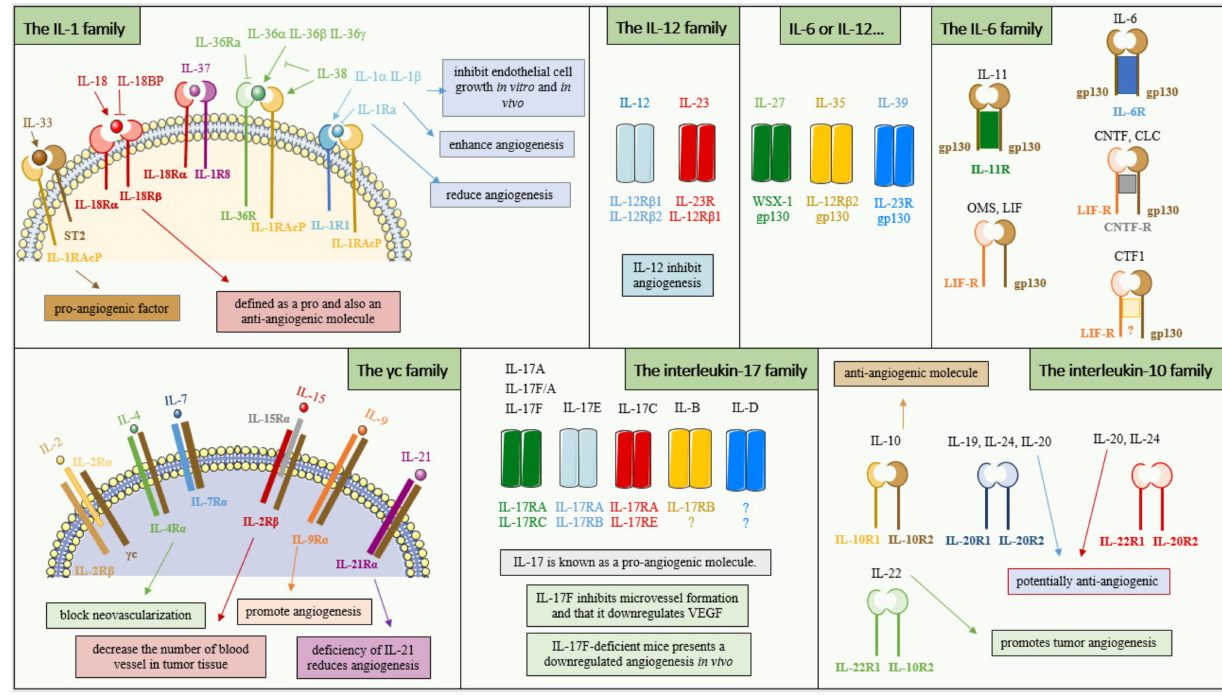
Figure 3. Role of cytokines in